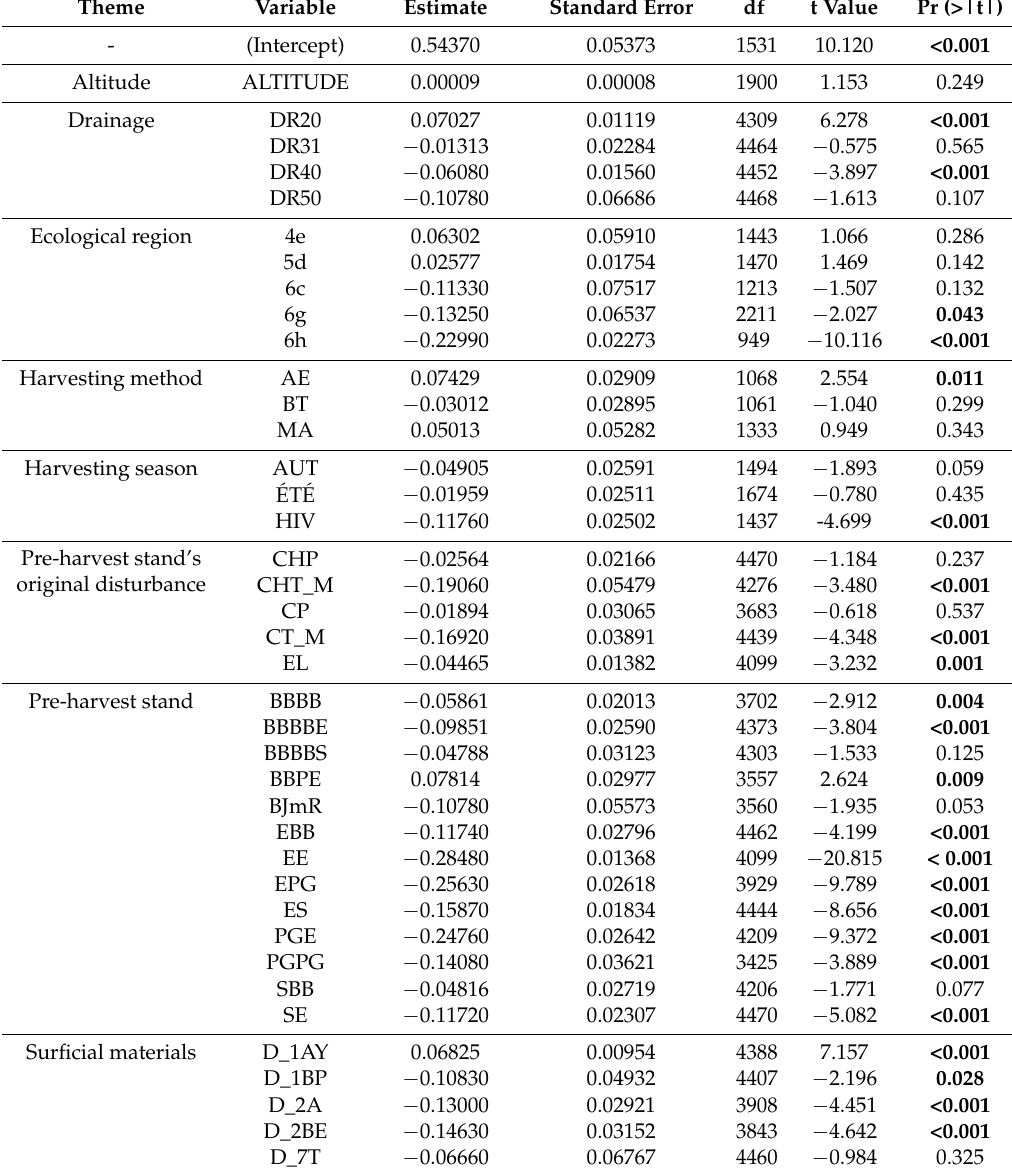
Table 3. Summary of the linear mixed models predicting commercial shade-intolerant hardwood stocking as a function of harvesting and biophysical